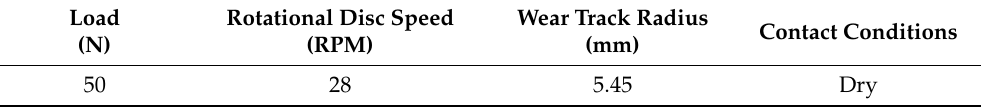
Figure 2. Roller-on-disc test apparatus and its components. The same facility was used in our previous study on the tribological properties of 410L, SS420, Stellite 6, and newly developed SS415 claddings [10,12]. Table 2. Roller-on-disc wear test